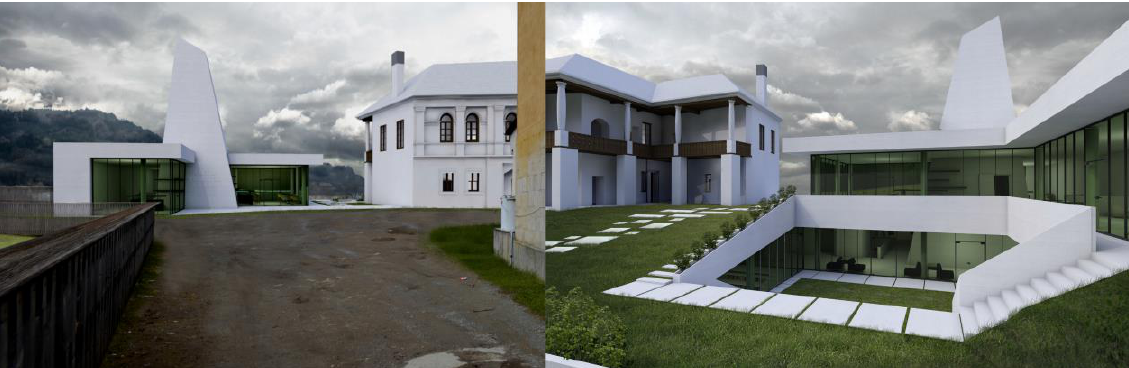
Figures 25, 26: Project for Roşia Montană Community Centre- front and backyard